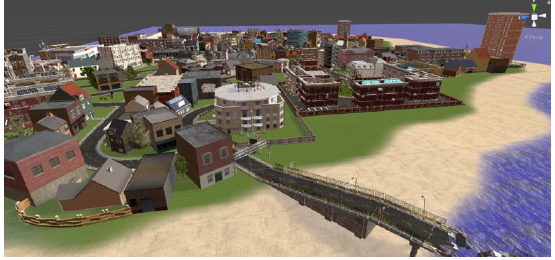
Figure 4: Seahaven - Surrounded by an ocean, the subject is forced to stay in the city. Many different houses and streets can be